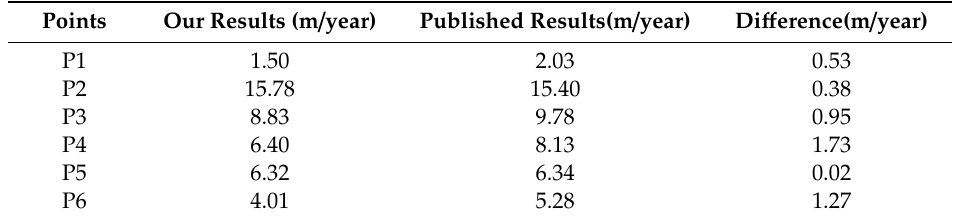
Table 2. Comparison of glaciers flow velocity in horizontal direction between our results and published ones (Dehecq et al.